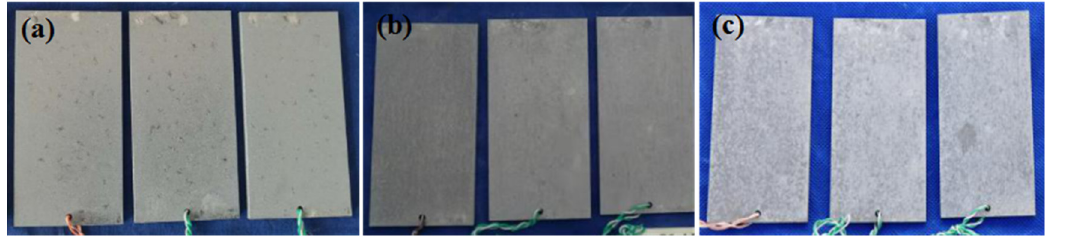
Figure 3. Macroscopic morphologies of the 7075 alloy after exposure at different time points in the marine atmospheric environment: ( a ) 1 month, ( b ) 6 months, and ( c ) 12 months.